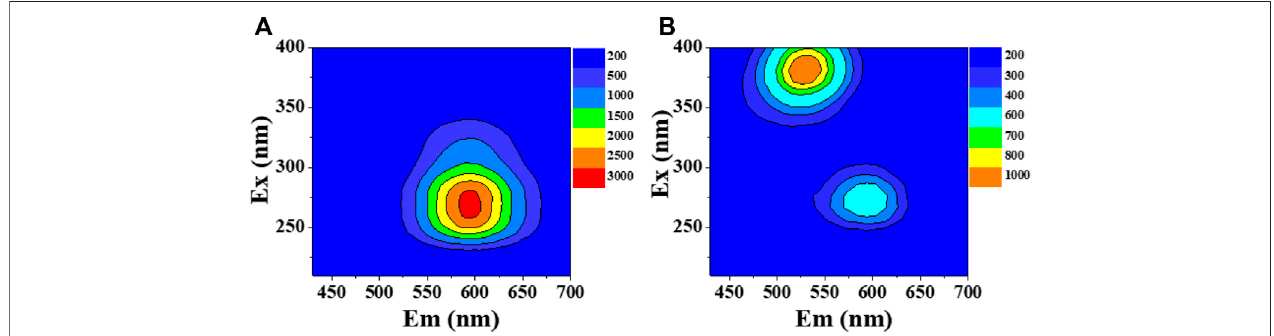
FIGURE 2 | 3D fl uorescence emission spectra of hPEI-Au NCs in the absence (A) and presence of (B) DA.